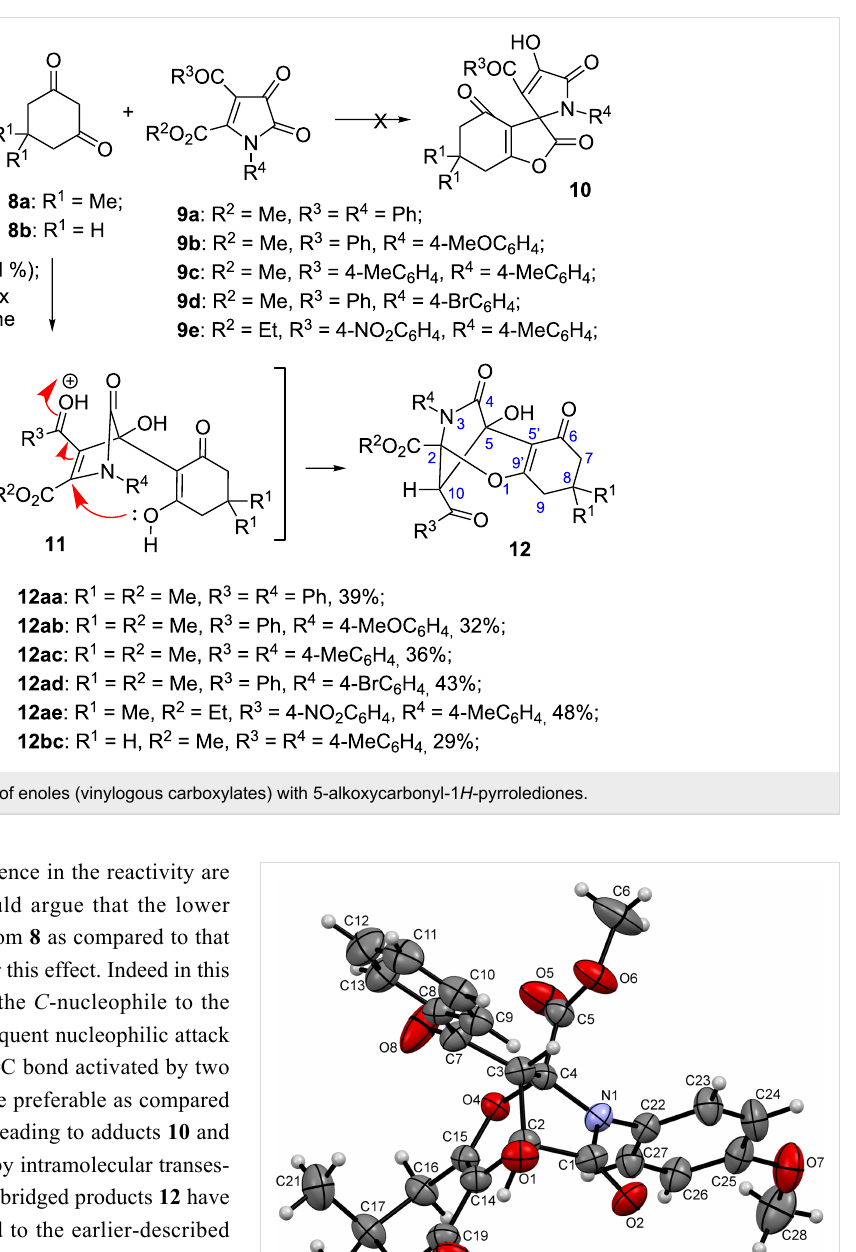
reported to favor enol-hydrazone tautomer 16 (Scheme 4) [46-